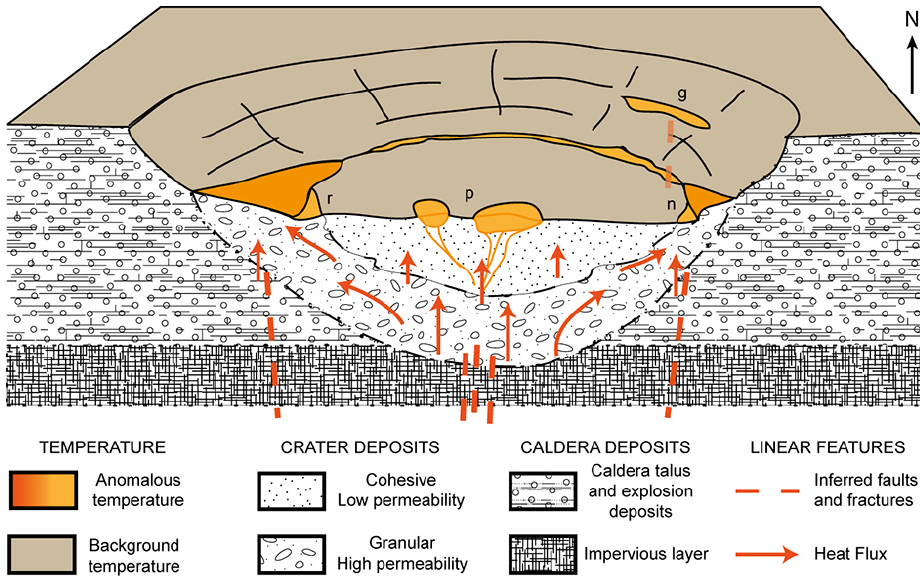
Fig. 8. Sketch (not to scale) of the conceptual model. At the bottom an impervious layer is broken by faults that drive the phreatic explosion through the caldera talus and the deposits of an older eruption. On top of the impervious layer is the crater. The heat rising from the depths enters the crater through the faults and propagates upward. According to our hypothesis, the crater is initially filled by granular and permeable deposits that progressively appear only at the sides. Later cohesive and impermeable material deposits on top of and in heteropy to the coarse ones. The heat flux rises with different efficiency: high in granular deposits (longer arrows), low in cohesive deposits (shorter arrows). Because of the low permeability at the crater center, fluids are forced to move sideways, increasing the degassing at the border. Possibly there are also other sideways faults that enhance the heat release at the NW and SE sites (r, n) and funnel hot fluids higher along the NE flank (g). Fault(s) at the crater center are also responsible for drainage and erosion of the crater filling, by which finally mud pits generate (p). At the surface, the thermal anomalies are presented in light and dark orange to indicate temperature differences. Brown is the cool terrain corresponding to the background